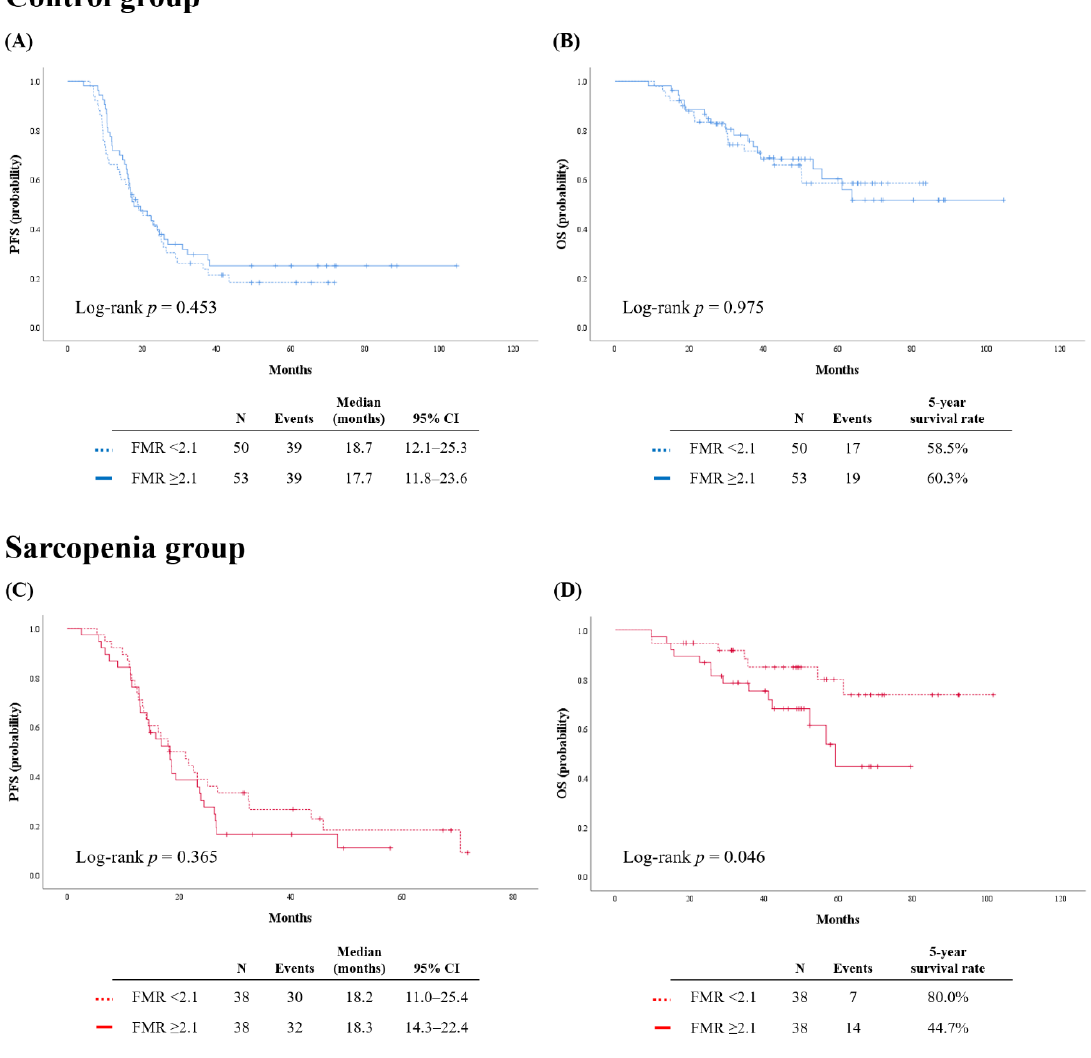
Figure 2. Survival outcomes of patients by fat-to-muscle ratio. (Upper) Control group; (Lower) sarcopenia group. ( A , C ) Progression-free survival; ( B , D ) overall survival.